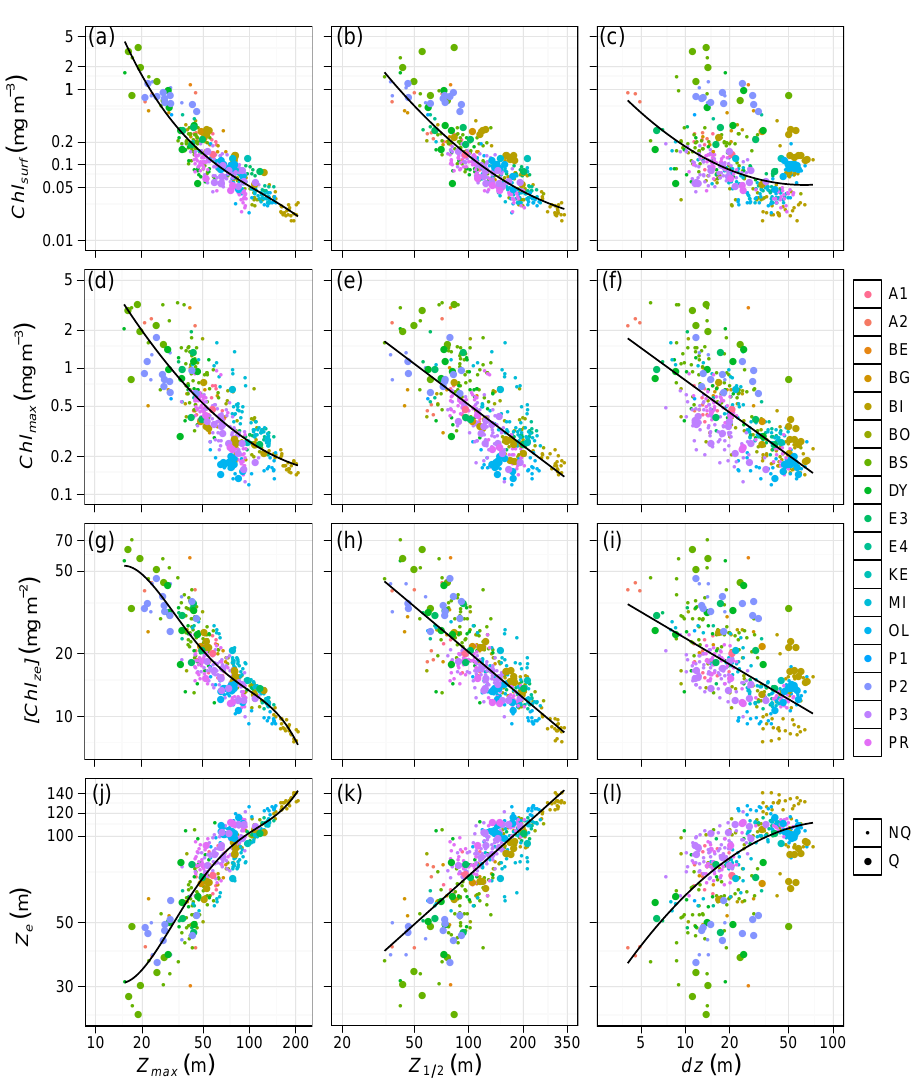
Fig. 7. Impact of quenching on the relationships presented in Fig. 4 (gaussian profiles). The quenched status of the fluorescence profile is indicated by the size of the symbol. Large circle: quenched profile. Small circle: non-quenched